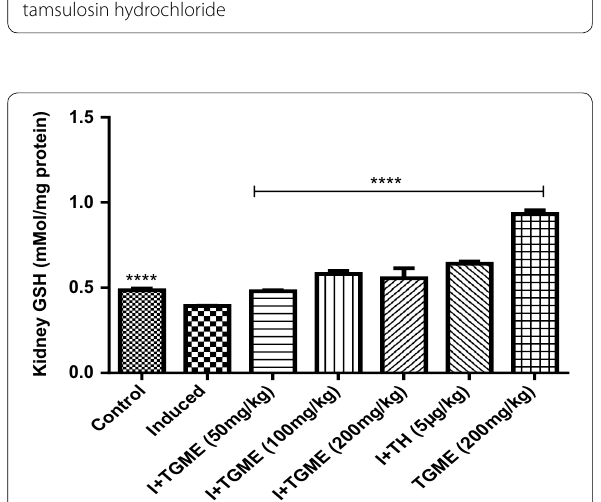
Fig. 10 Effect of aqueous methanolic leaf extract of Triclisia gilletii on concentration of GSH in the kidney of animals administered ethane-1,2-diol. Data are expressed as mean * < 0.05, *** p < 0.001, and **** p < 0.0001; *denotes that data were compared with ethane-1,2-diol; TGME Triclisia gilletii aqueous methanolic extract, TH tamsulosin hydrochloride, GSH reduced